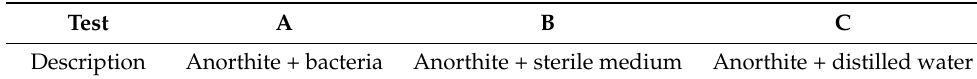
Table 2. Leaching test group for anorthite samples.